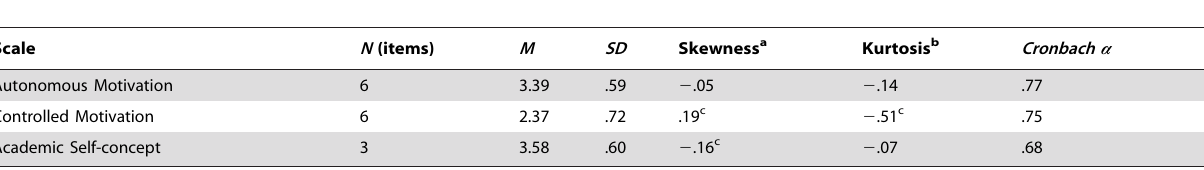
Table 1. Descriptive Statistics of Motivational